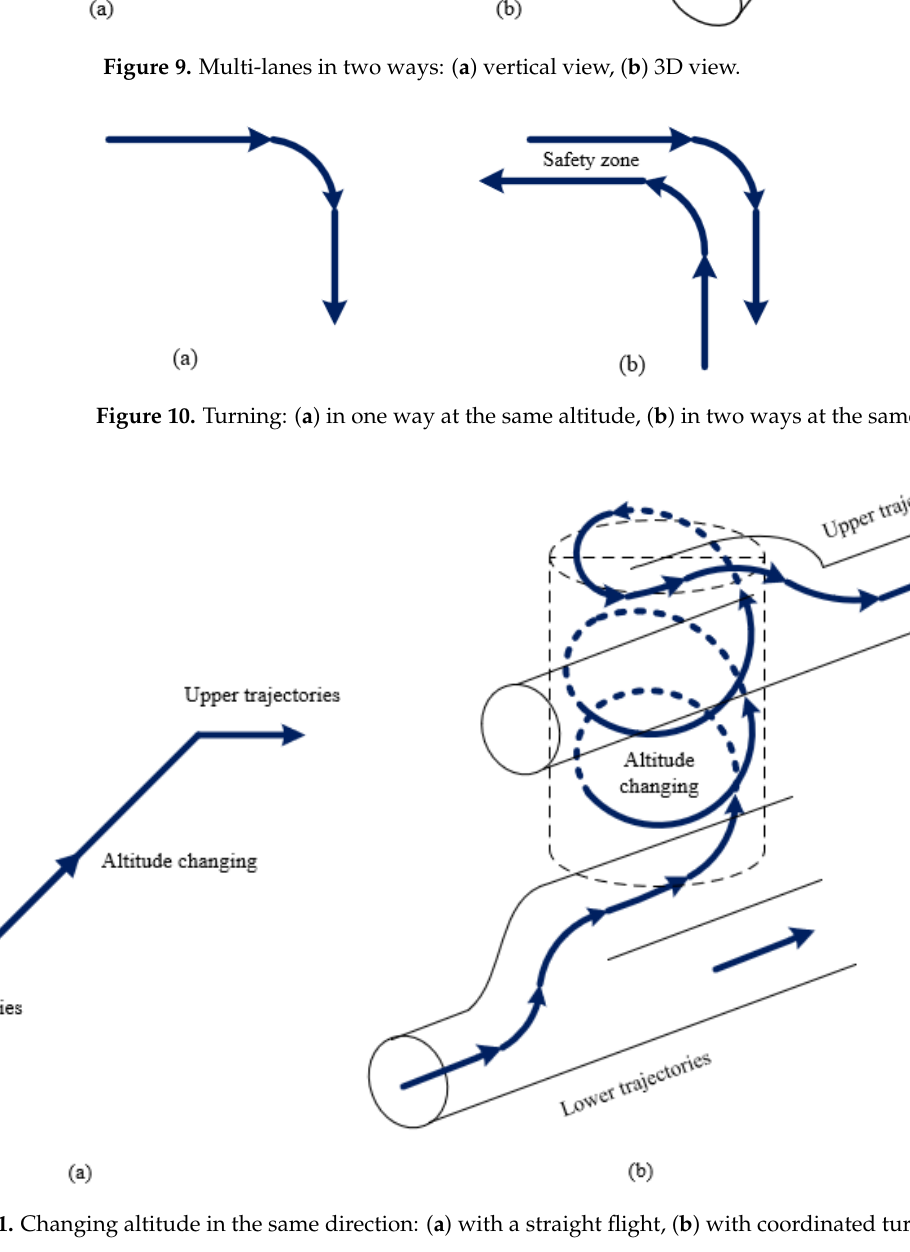
(Figure 12b). Figure 12. Crossing: ( a ) changing lane, ( b ) changing heading (in top view). However, changing the direction (or heading) is not as straightforward. To minimize the number of potential conflicts, lanes of different headings are at different altitudes. Thus, heading modifications lead to the following six simple maneuvers, as shown in Fig- ure 13.